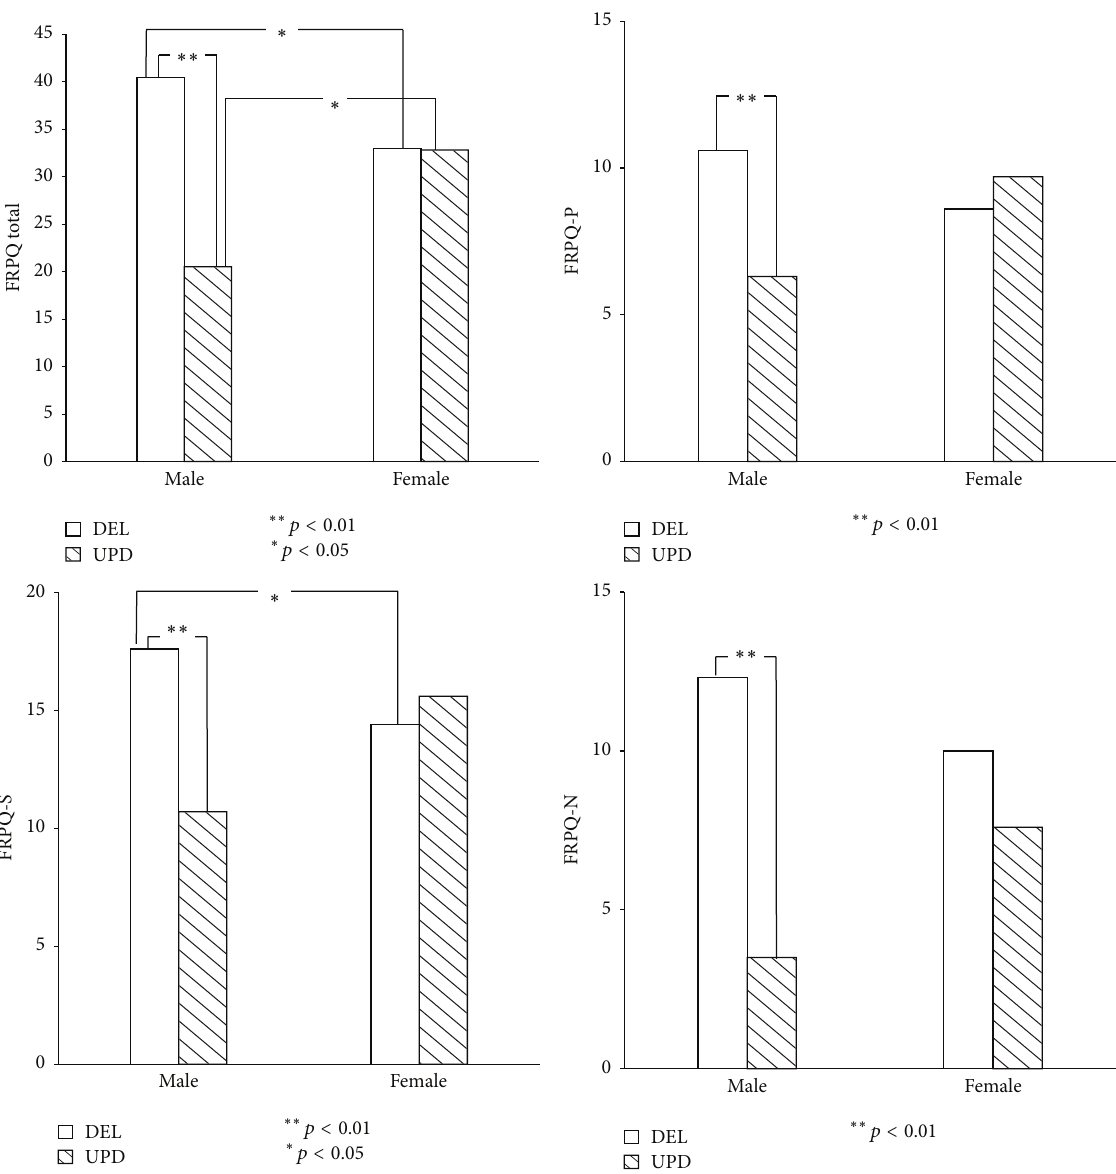
Figure 1: The effect of gender (male versus female) and genotype (DEL versus UPD) of PWS on the total score and preoccupation (P), impairment of satiety (S), and composite negative behavior (N) domains of